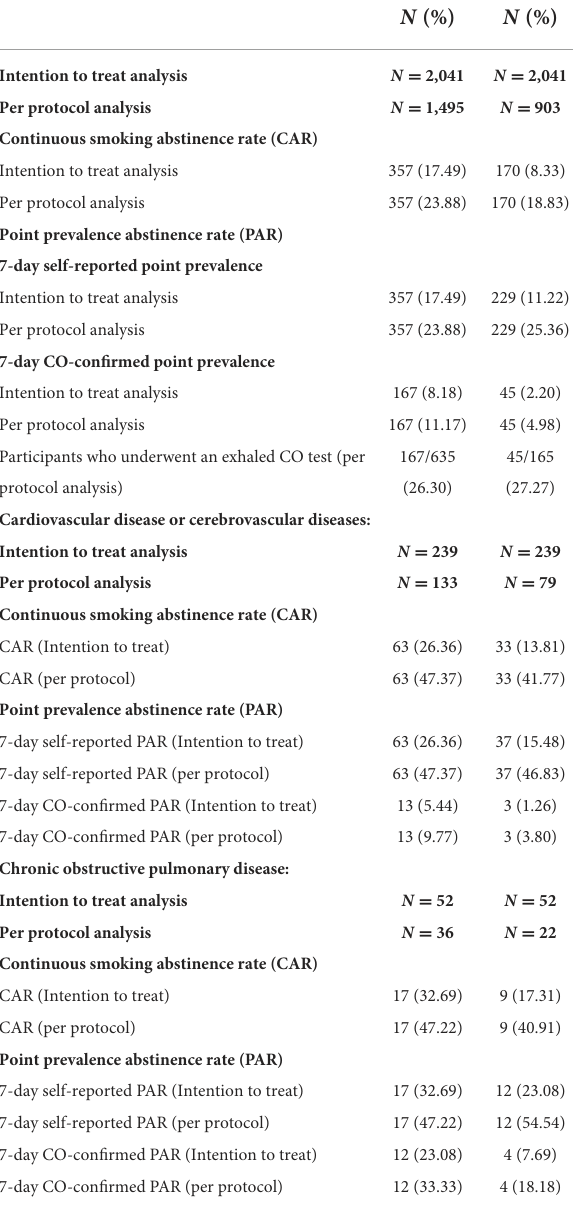
TABLE 3 Smoking cessation outcomes in overall participants, and smoking cessation outcomes among patients with CVD or cerebrovascular disease, and